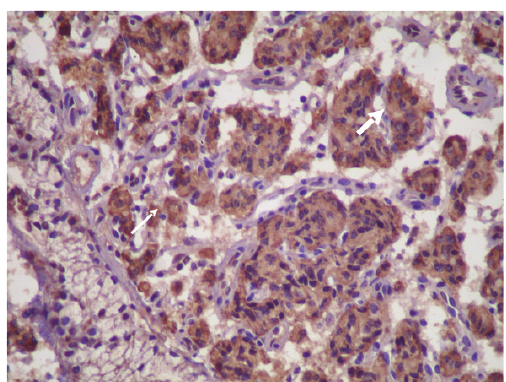
Figure 6- Somatostatin immunoreactivity in the ampullar lesion displaying uniform intense staining. Tumor cells were visible in this serotonin- containing carcinoid tumor of the minor ampulla (large arrow). Ductal epithelial cells are negative. Medium-to-large cells with pale, granular